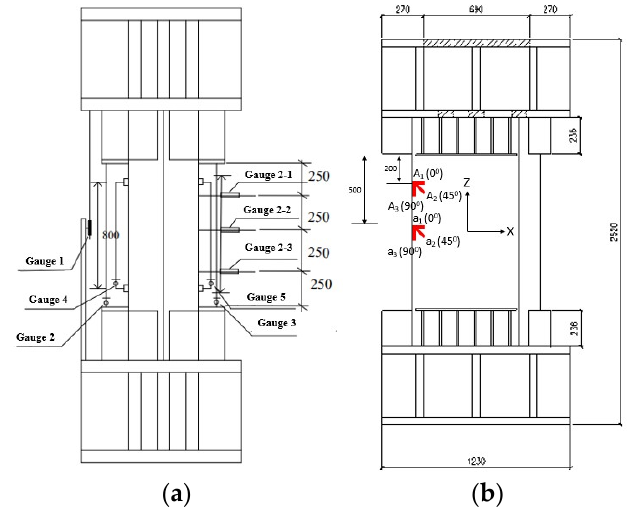
Figure 5. Locations of displacement and strain gauges. ( a ) Displacement gauges; ( b ) Strain gauges near the welded corner.